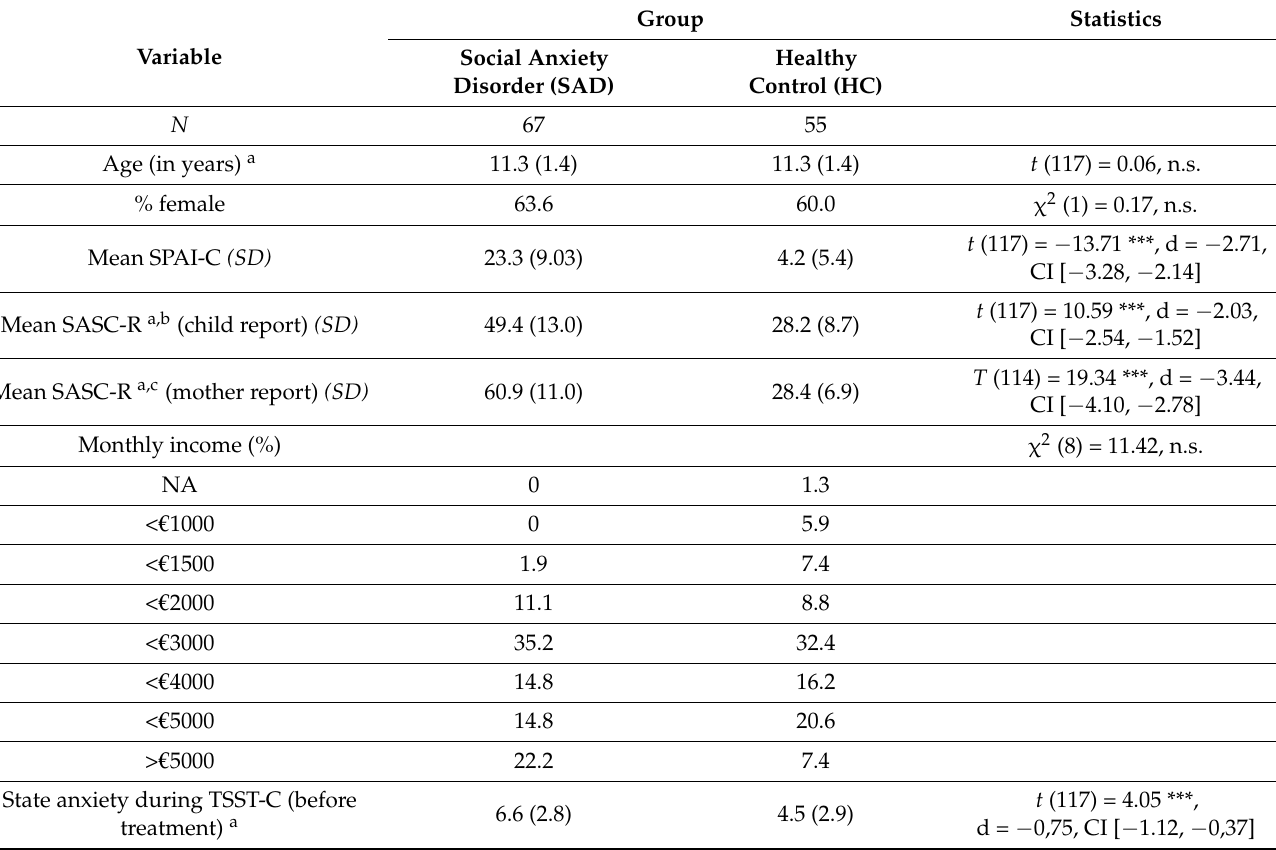
Table 1. Participant Characteristics: Social Anxiety Disorder Versus Healthy Control Group.